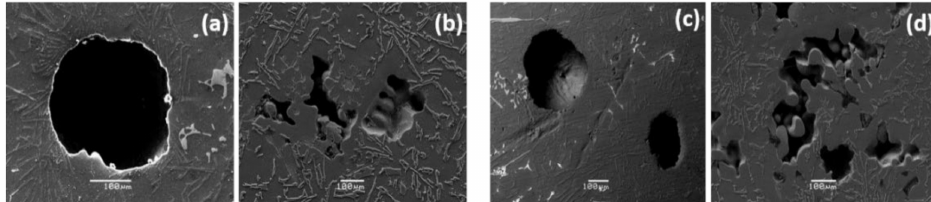
Figure 7. Micrographs obtained by SEM revealing the porosity present in the samples solidified in binder jetting mold ( a , b ) and in sand mold ( c , d ).